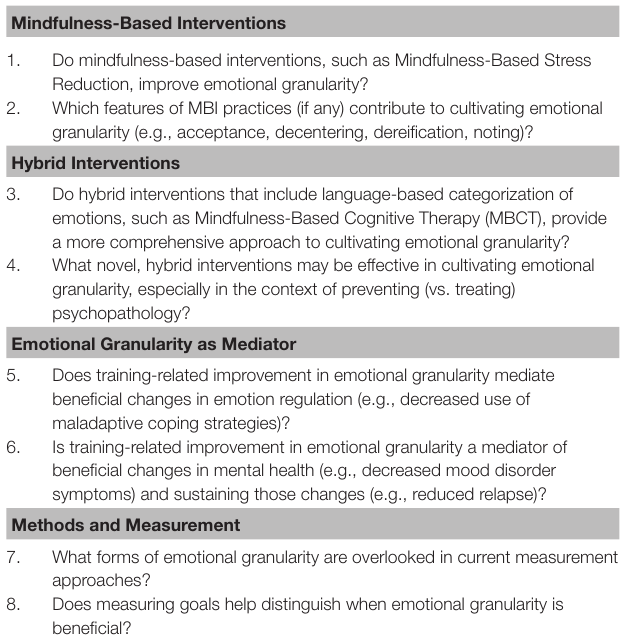
TABLE 2 | Questions for future research on cultivating emotional